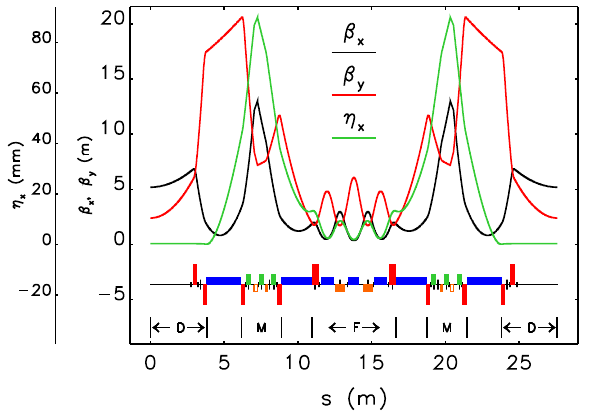
FIG. 1. Lattice functions for one sector of the APS-U storage ring, broken into doublet (D), multiplet (M), and FODO (F) sections. Blue objects are normal-direction dipoles, orange objects are reverse-direction dipoles, red objects are quadrupoles, and green objects are sextupoles. Skew quadrupole and (poten- tial) octupole magnets are incorporated into eight-pole magnets in the doublet and multiplet sections, but these are not